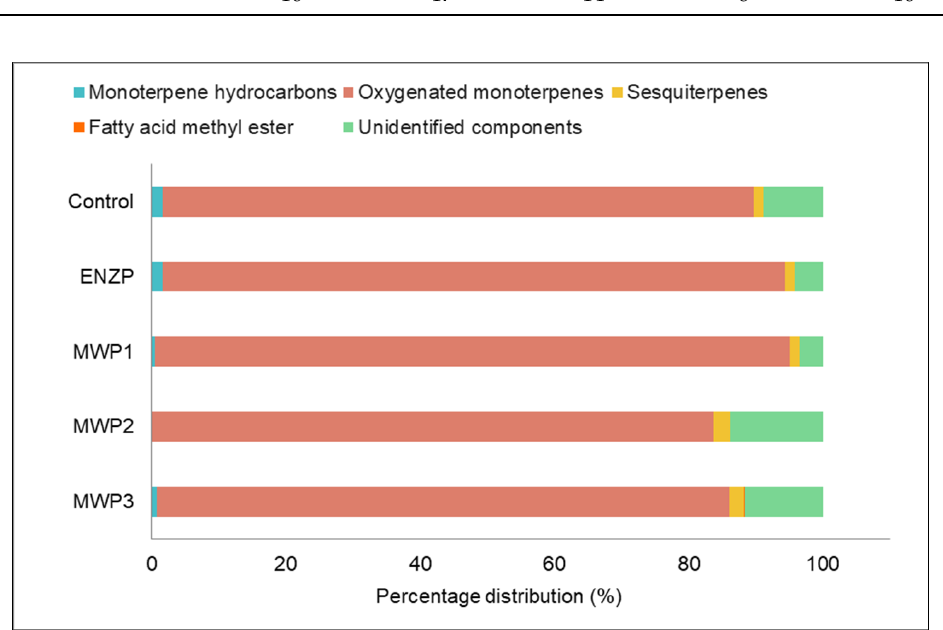
Figure 3. Percentage distribution of groups of aromatic compounds in oregano extracts obtained by supercritical carbon dioxide extraction (pressure 200 bar, temperature 40 °C, extraction time 4 h).